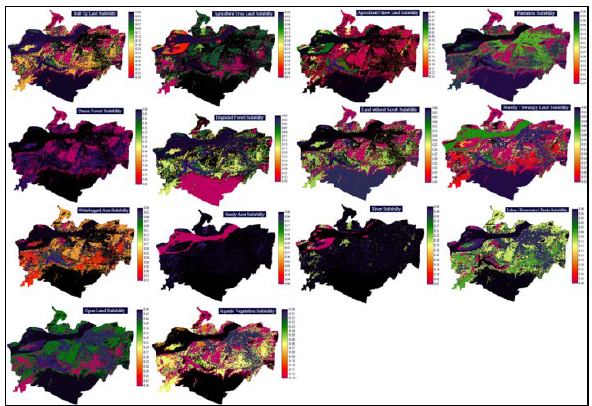
Figure 3: Suitability (evidence likelihood) map used to predict future